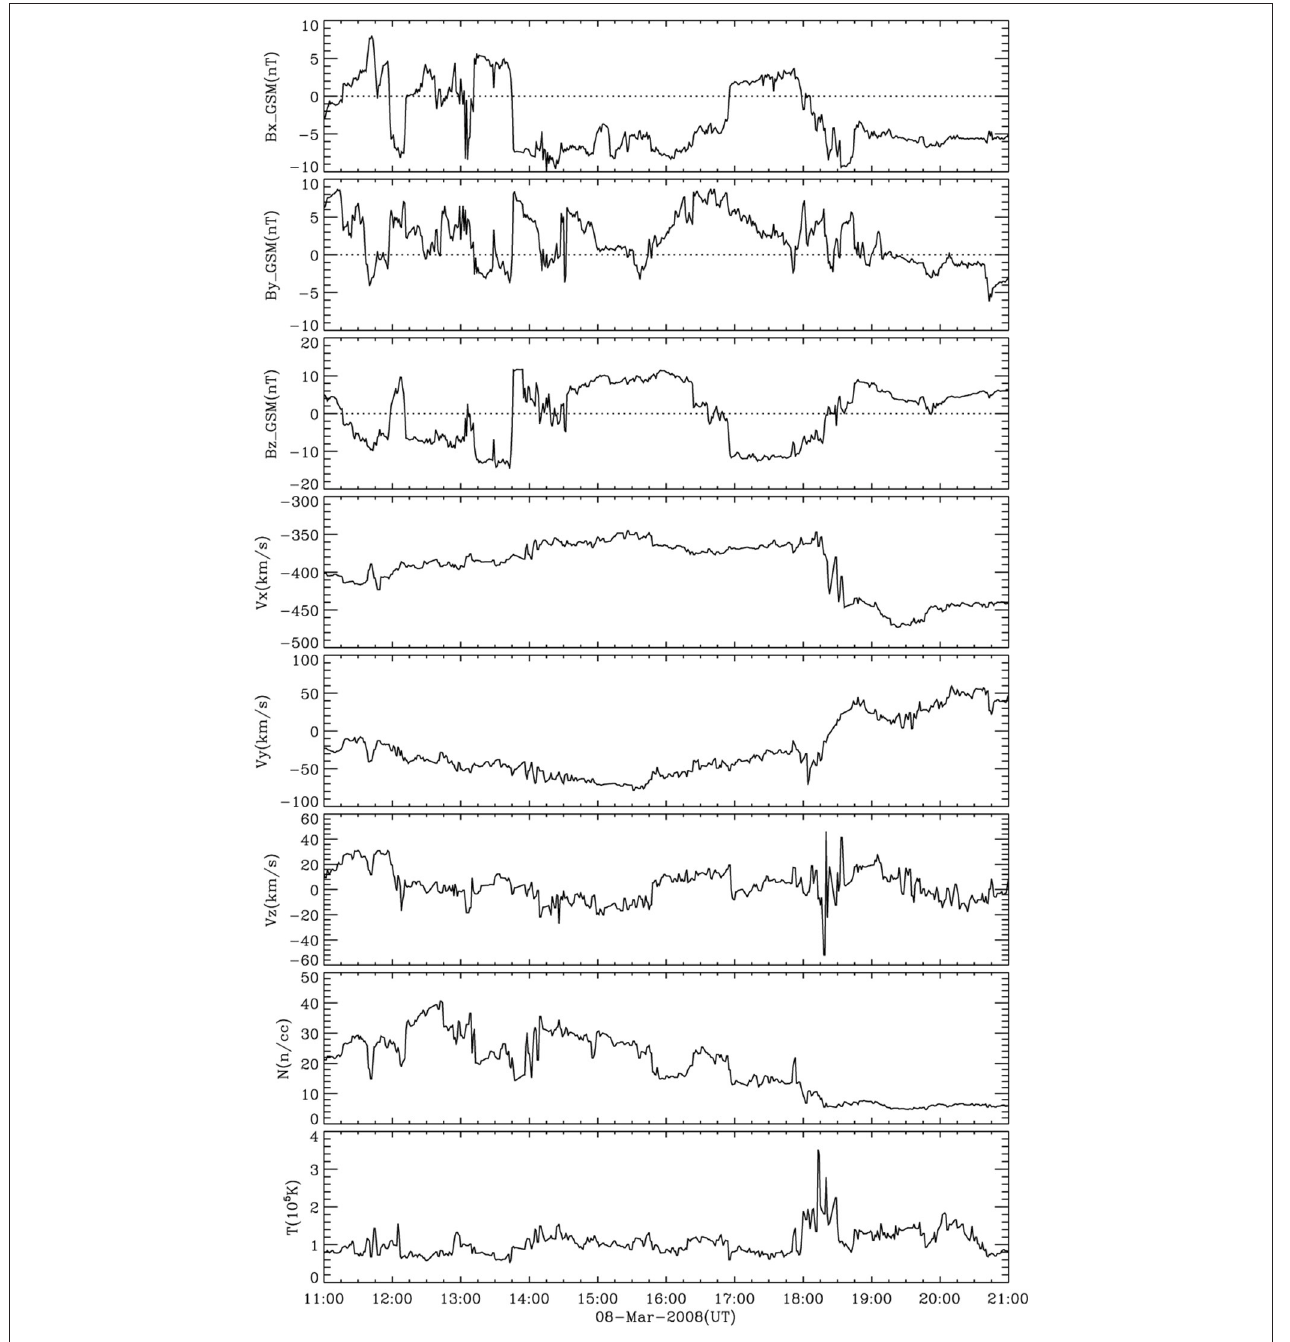
FIGURE 2 | Solar wind properties of the 8 March 2008 event from the OMNI data; From the top to the bottom, the three components of interplanetary magnetic field (IMF) and solar wind velocity, the solar wind plasma number density and temperature, respectively.